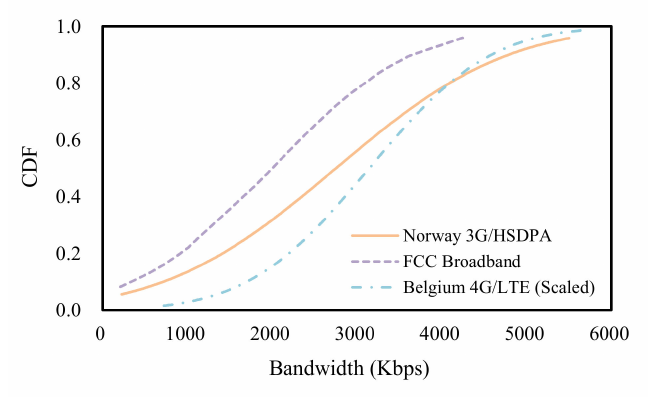
Figure 5. Bandwidth of network